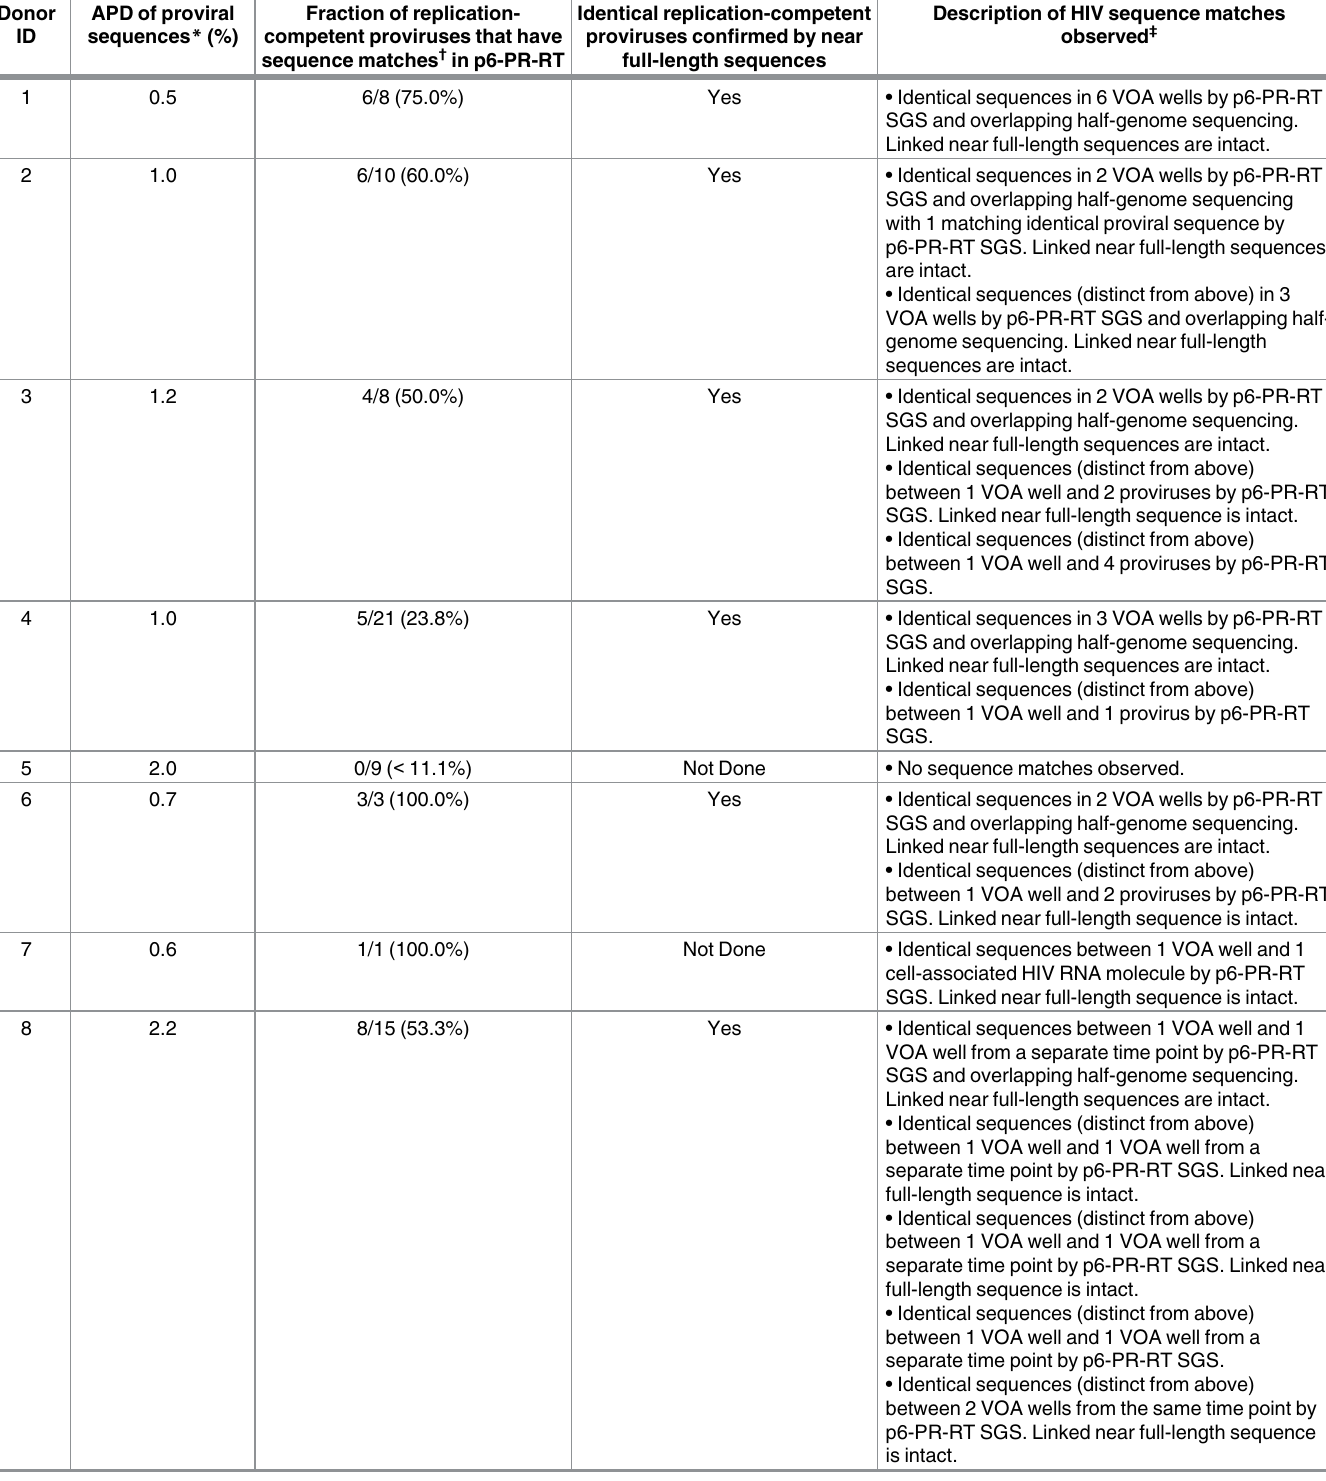
Table 2. Frequencies of identical replication-competent proviral